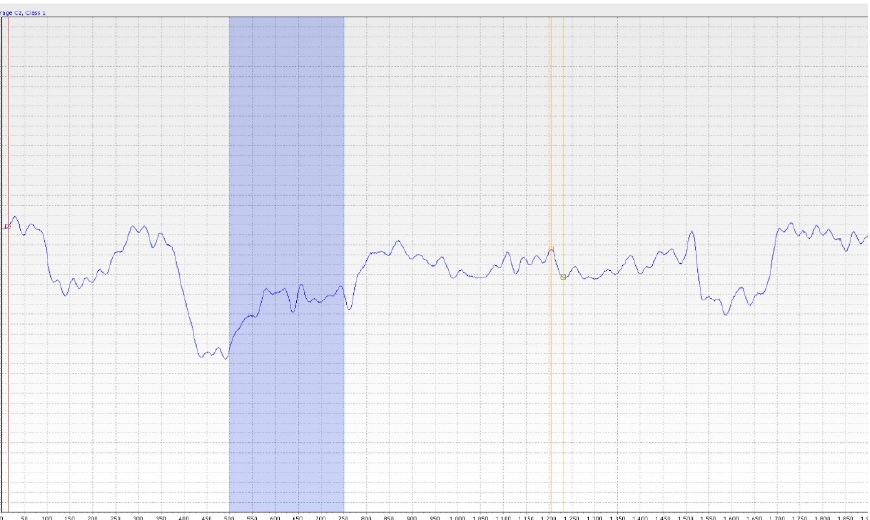
Figure 9. The curve of olfactory event-related potentials (OERP), Female 38 years old, healthy proband (from co-author’s archive).